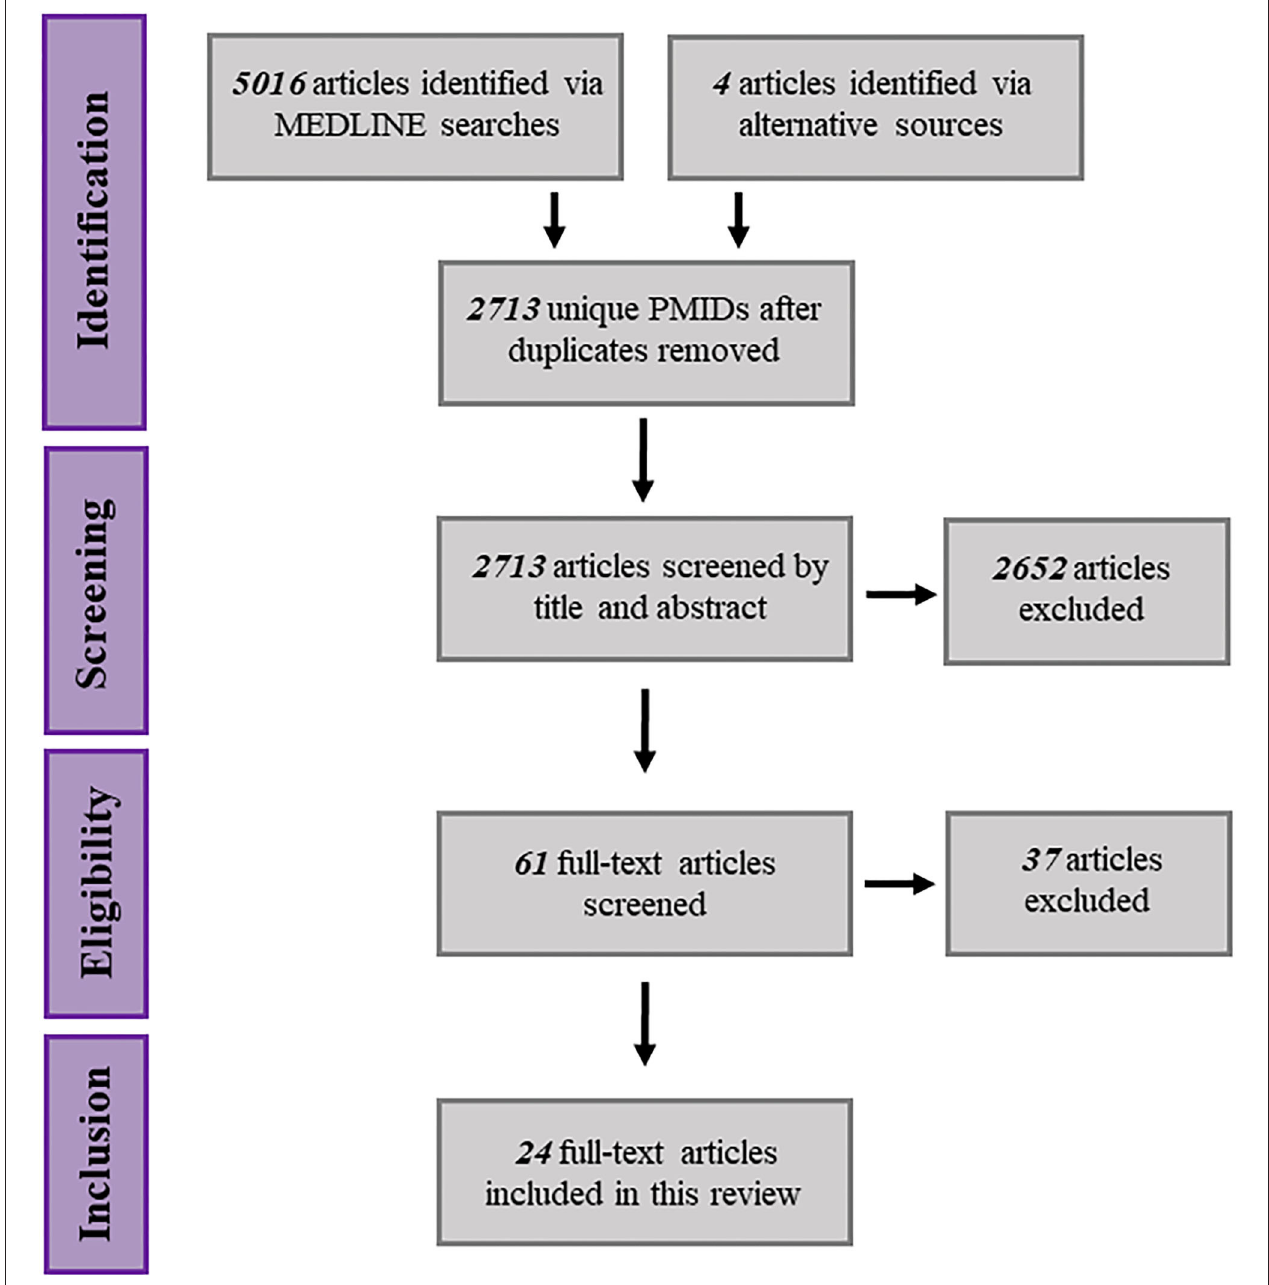
FIGURE 2 | Schematic representation of the systematic search procedure, spanning article identification, eligibility screening and inclusion.